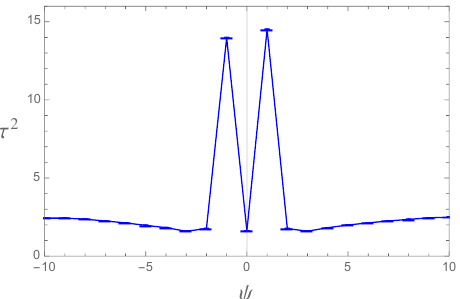
Figure 2 . The maximum Ricci scalar (left) and magnitude of the curvature squared invariant (right) on the points sampled for the Fermat K3 in P 3 as a function of k . The Ricci scalar approaches zero exponentially as k is increased while the higher curvature invariant approaches a (cid:12)xed value.